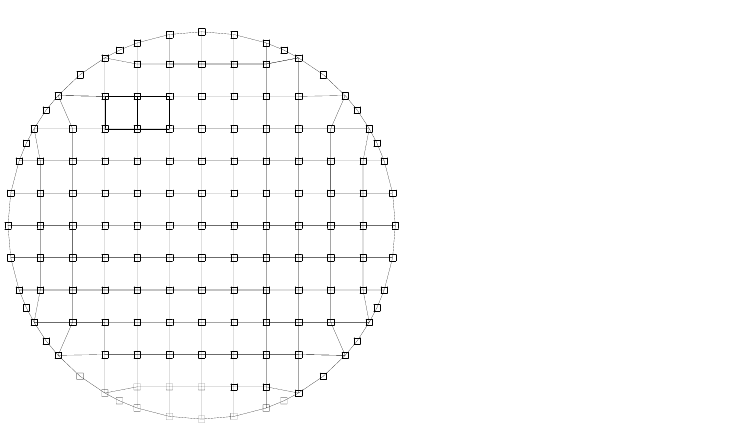
Figure 2. Quadrilateral elements cover the interior of the unit circle in the stereographic plane. The circle itself corresponds to the equator. Most of the interior elements are perfect squares. Elements with 1, 2, or 3 equatorial nodes are deformed quadrilaterals that conform to the